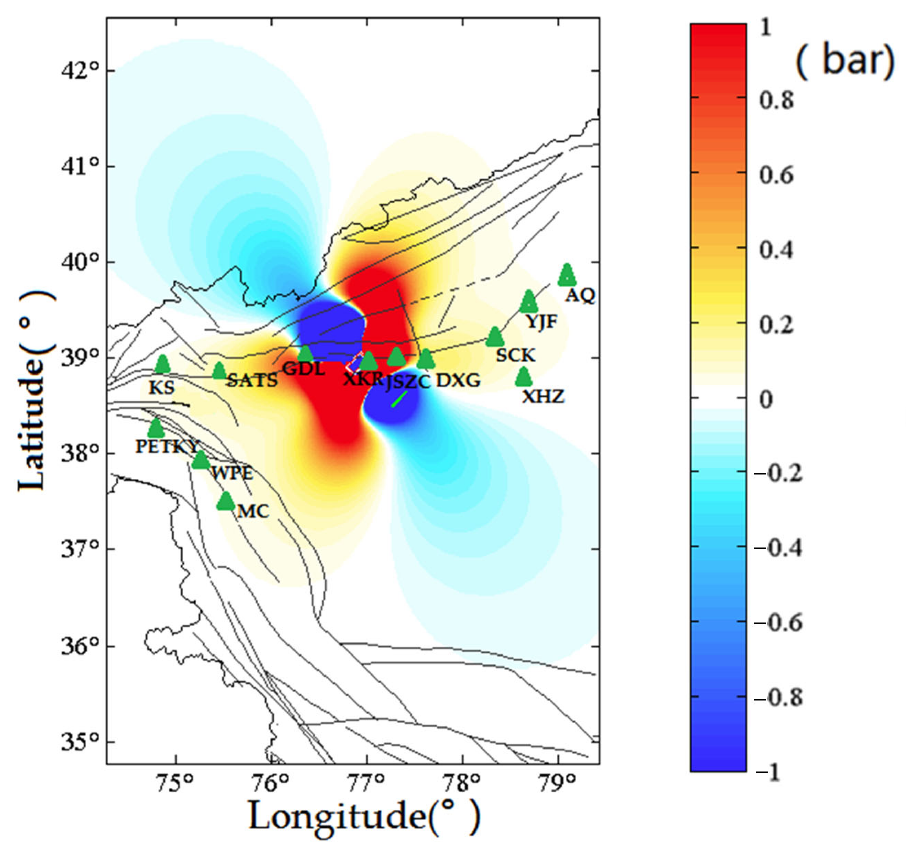
Figure 6. The coseismic Coulomb stress field of the Ms = 6.4 Jiashi earthquake by using the Coulomb 3.3. The software was downloaded from https://pubs.usgs.gov/of/2011/1060/ (accessed on 3 January 2016).